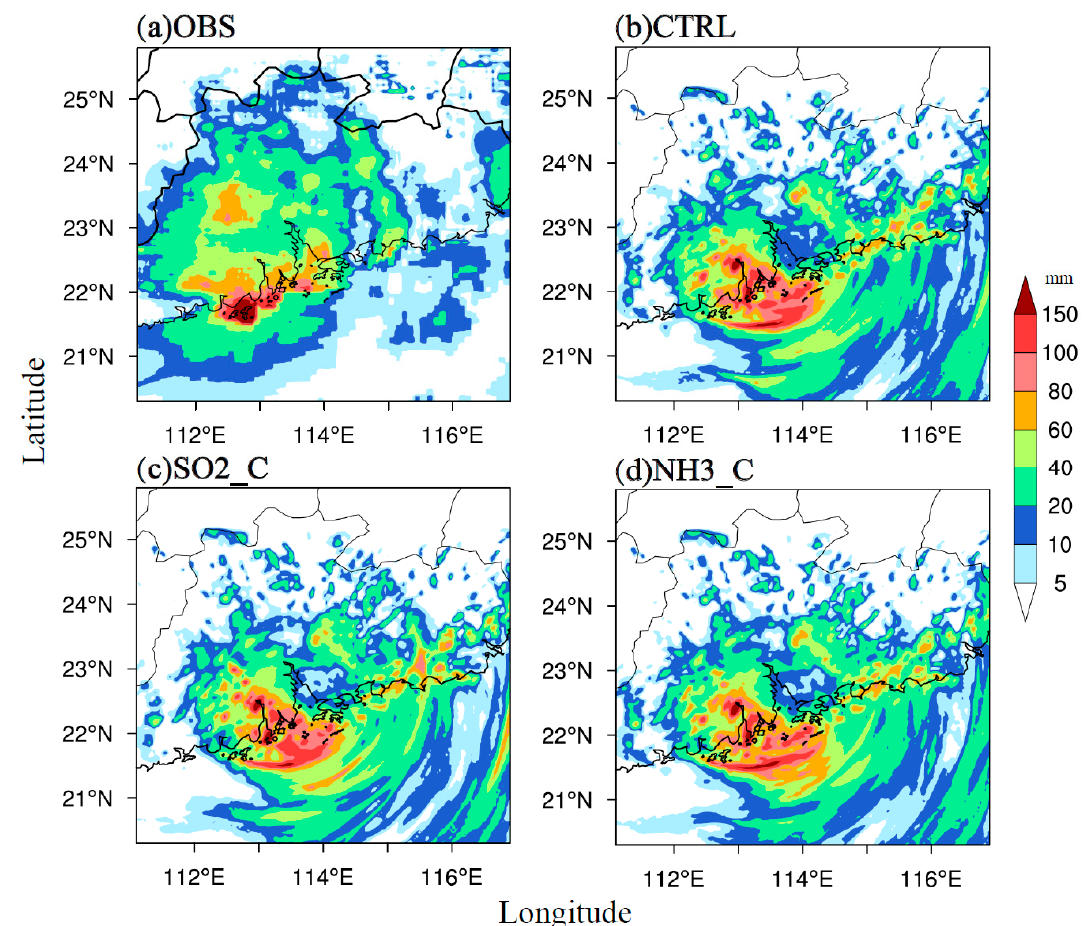
Figure 6. Spatial distributions of 6-h accumulated precipitation (mm) after landfalling from 0000 UTC to 0600 UTC 2 August from the ( a ) observation and ( b ) CTRL, ( c ) SO2_C and ( d ) NH3_C runs.